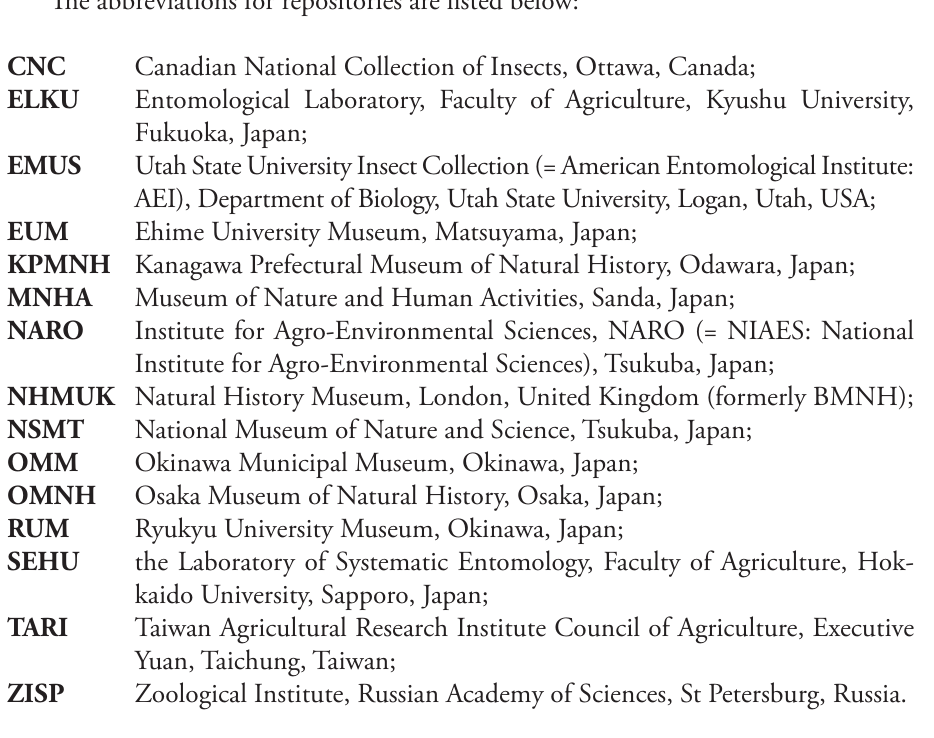
the proportion of males was analyzed using a generalized linear model (GLM). A